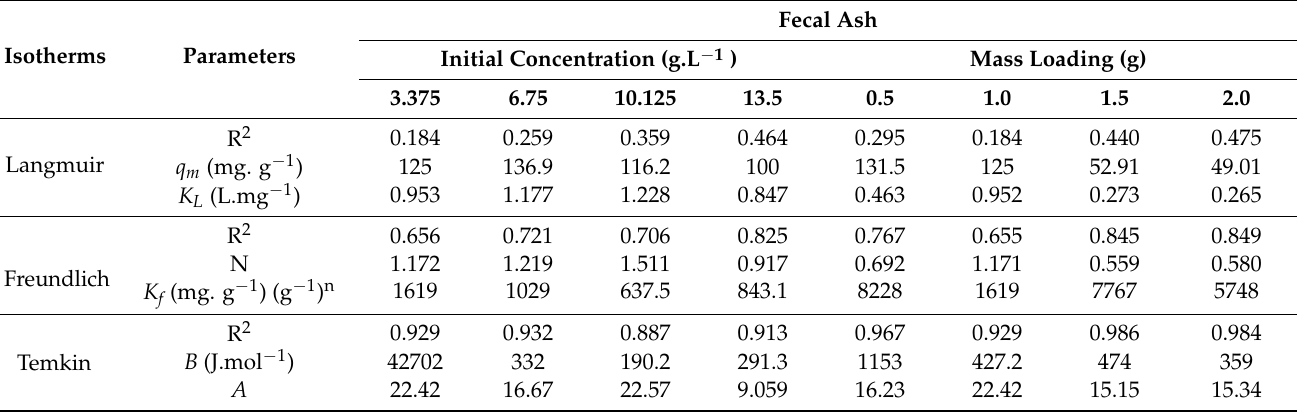
Table 2. Analysis of different types of isotherm models with two parameters for recovery of